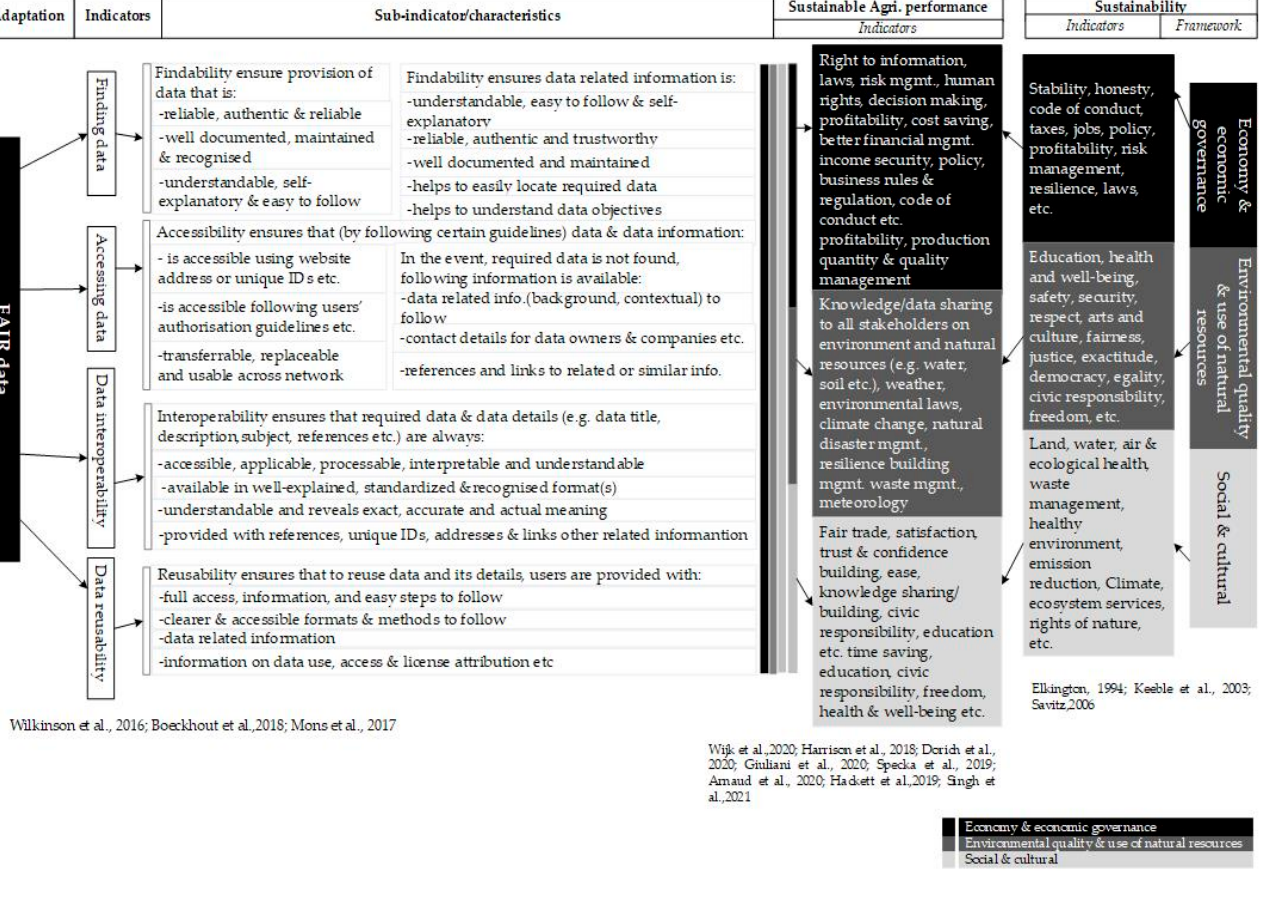
Figure 3. Indicators, sub-indicators, their impacts on sustainable agri. performance, & assimilation with sustainability framework. Table 4. Authors, objectives, and roles of FAIR data towards agricultural performance, scopes and sources or tools in the included studies.